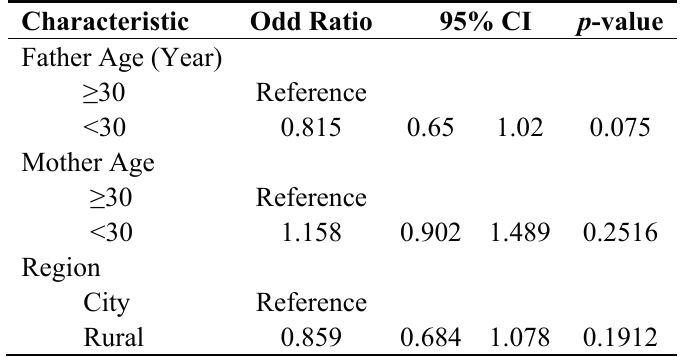
Table 2. Association of birth-sex and mother pregnancy